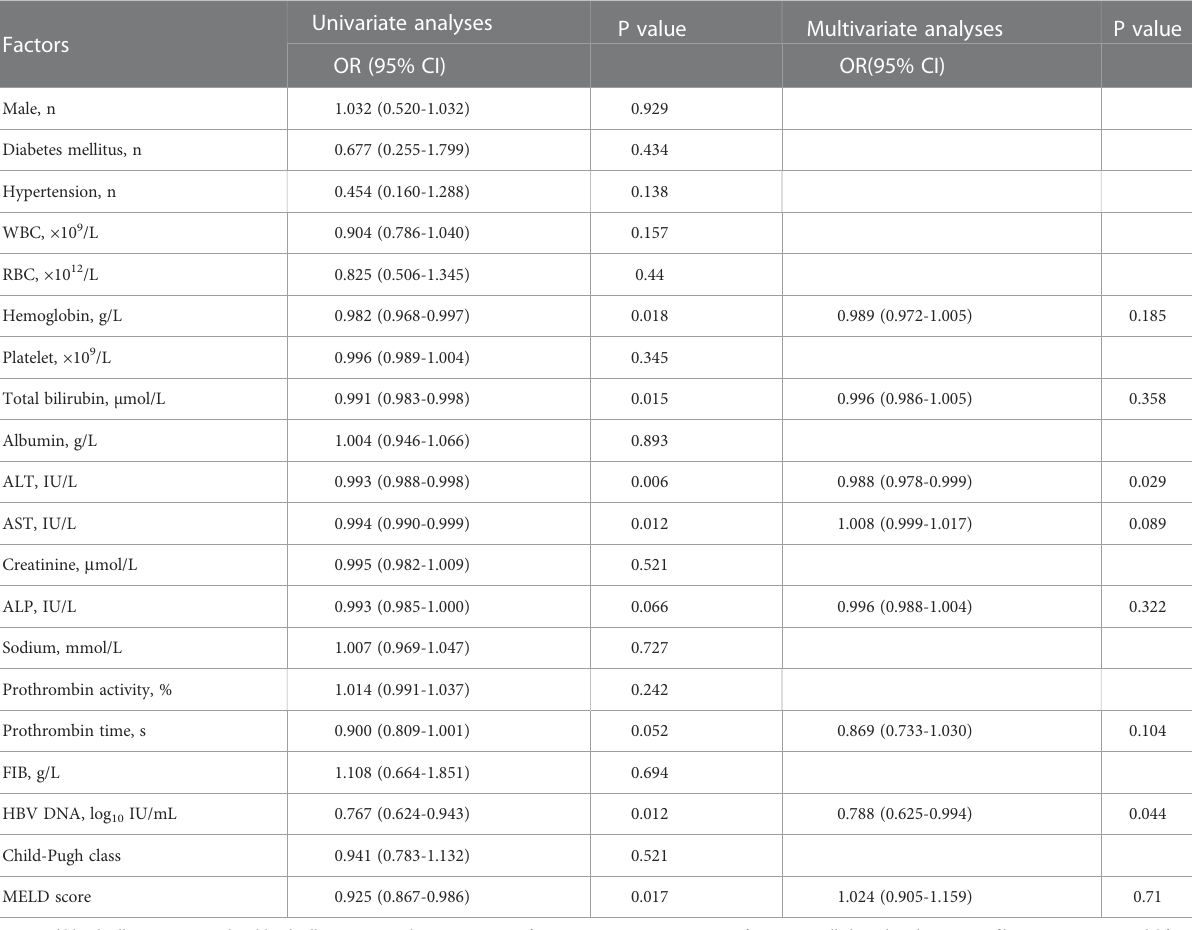
TABLE 2 Factors associated with re-compensation of ascites following NUC treatment in the total